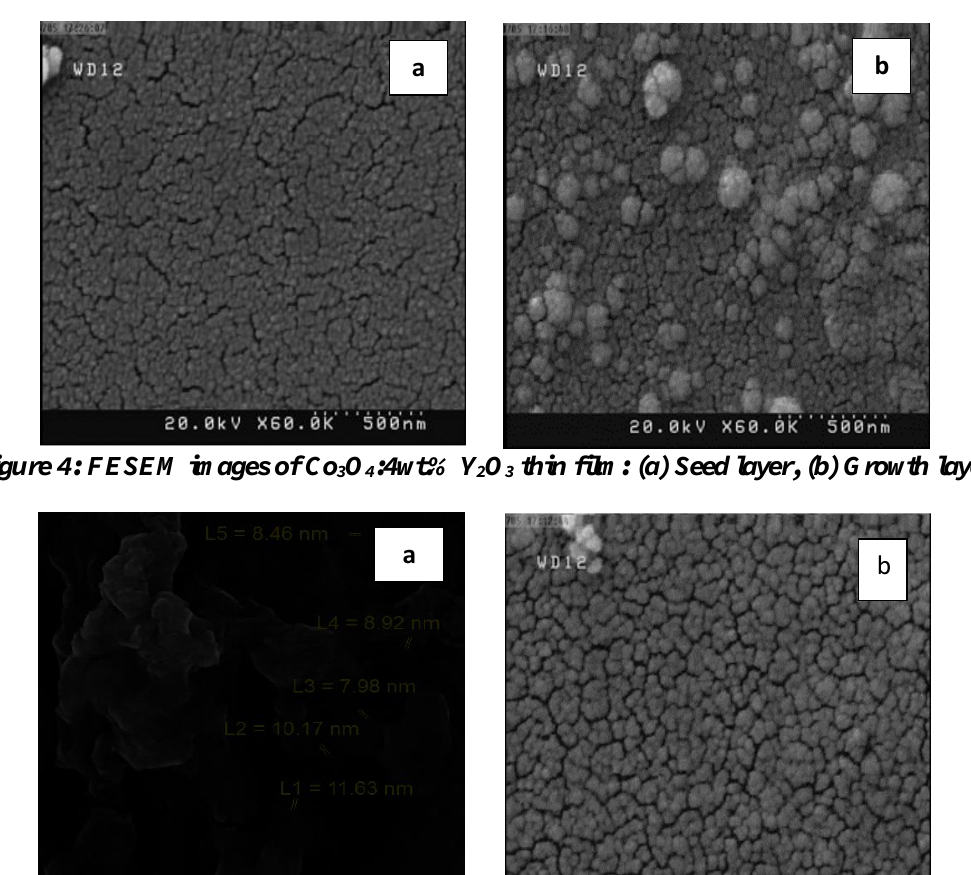
O :6wt. % Y O thin film: (a) Seed layer (b) Growth 3 4 2 3